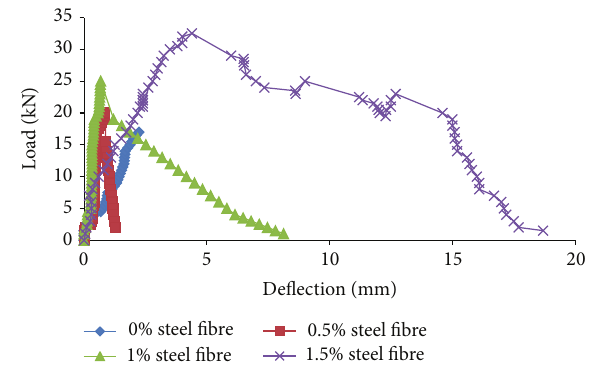
Figure 11: Load-deflection plots for various volume fraction of steel fibre reinforced geopolymer concretes at 28 days.